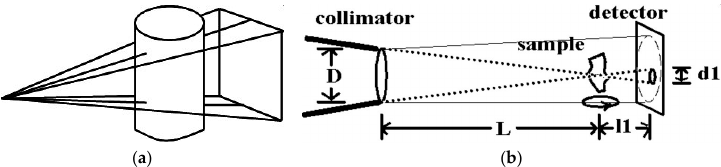
Figure 1. ( a ) This is a figure magnifying cone beam projection, ( b ) beam geometry for neutron imaging: Approximation to parallel beam.